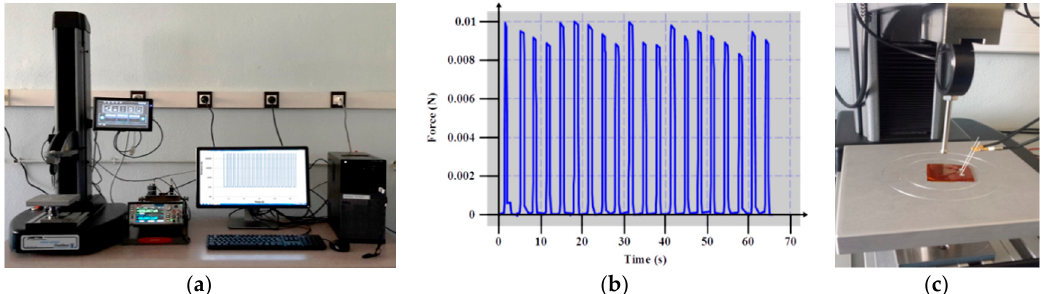
Figure 3. ( a ) Test bench permitting to apply ( b ) a controlled vertical force to the surface of ( c ) the sensor under test.